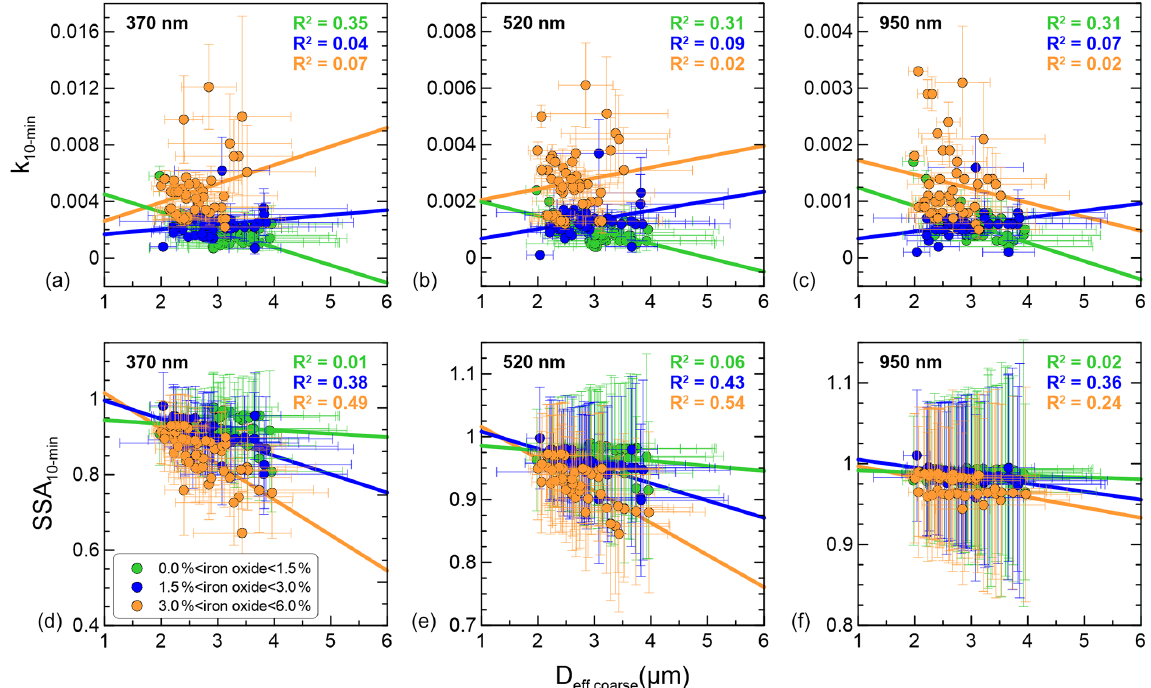
Figure 10. The 10min averaged imaginary refractive index ( k 10min , a , b , c ) and single-scattering albedo (SSA 10min , d , e , f ) at 370, 520, and 950nm versus effective coarse diameter ( D eff , coarse ) estimated at the input of the SW instruments. Data were classified into three classes based on the iron oxide content of the dust samples. The linear fit curves and the correlation coefficients for the linear regression fits for each dataset are also reported. The legend identifies the line styles used in the